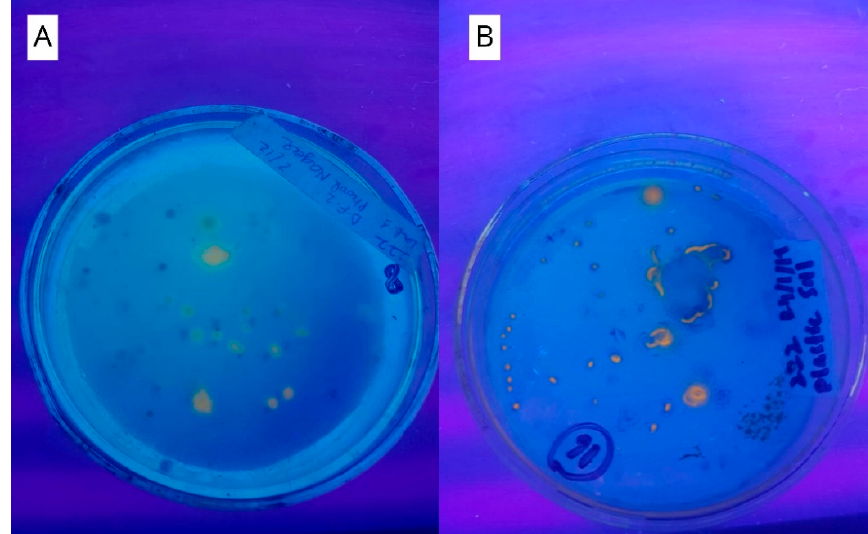
Figure 1. PHA producing samples inoculated on PHA detecting agar, exhibiting fluorescence under UV light. ( A ) Shows a petri plate of sample 8 and ( B ) shows growth on the petri plate by sample 16.